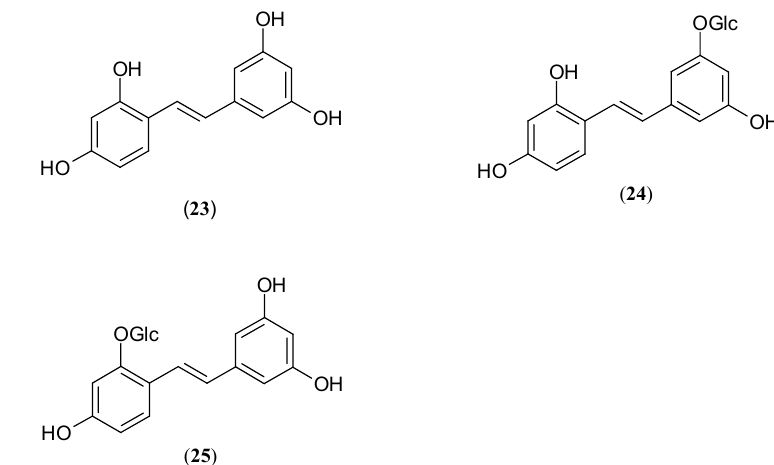
Figure 6. Structures of stilbenes: mulberroside A (22 ), oxyresveratrol ( 23 ), oxyresveratrol-3′-O-β-D-glucopyranoside ( 24 ), oxyresveratrol-2-O-β-D-glucopyranoside ( 25 ) with tyrosinase inhibitory activity isolated from genus Morus .